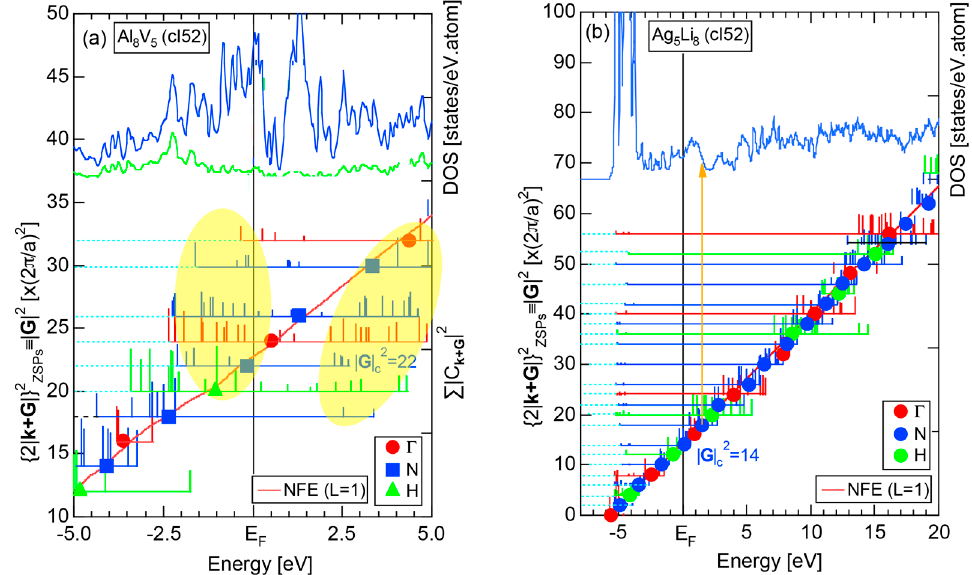
Figure 38. FLAPW-Fourier spectra at symmetry points Γ , N and H of the bcc Brillouin zone along with the total DOS for ( a ) Al 8 V 5 (cI52) and ( b ) Ag 5 Li 8 (cI52). A green curve in ( a ) represents the Al-3p pDOS. Formation of bonding and anti-bonding states due to V-3d-states-mediated splitting is highlighted by yellow color in ( a ). An orange vertical line in ( b ) is drawn so as to pass the energy corresponding to the center of gravity energy state with | G | 2 = 18. It meets the pseudogap in the total DOS in Ag 5 Li 8 (cI52).